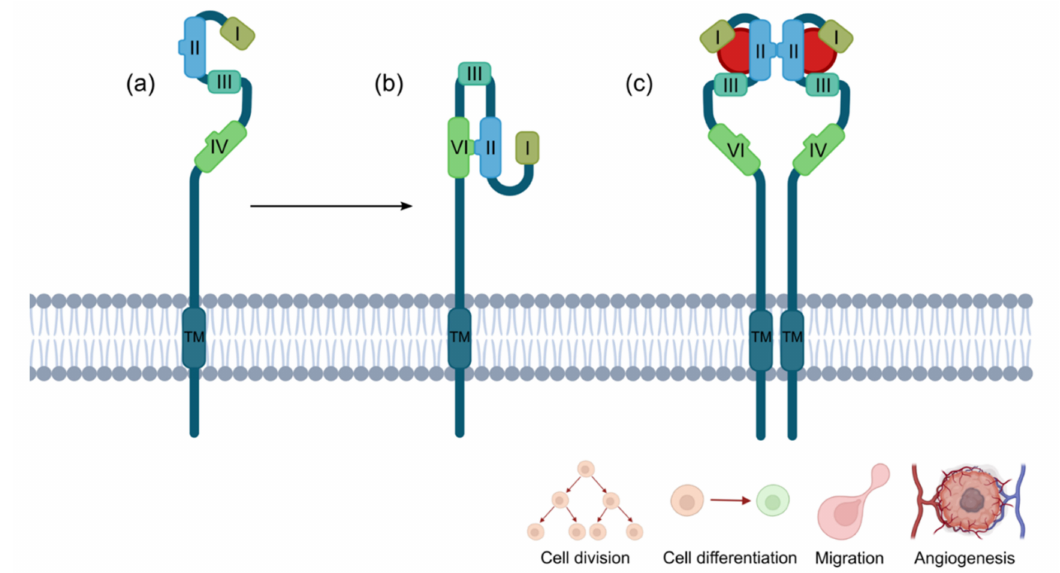
Figure 5. EGFR structure and conformation: ( a ) open conformation (active) and ( b ) closed con- formation (inactive); ( c ) the ligand binding drives EGFR dimerization and activates the signaling cascade, with consequent stimulation of cell division and differentiation, as well as migration and angiogenesis. Created with